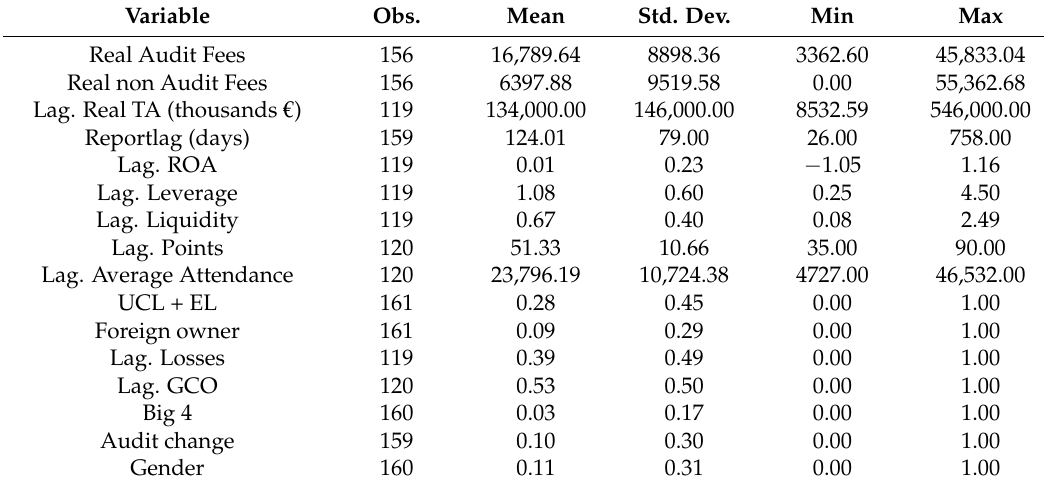
Table 6. Descriptive statistics (financial variables in real